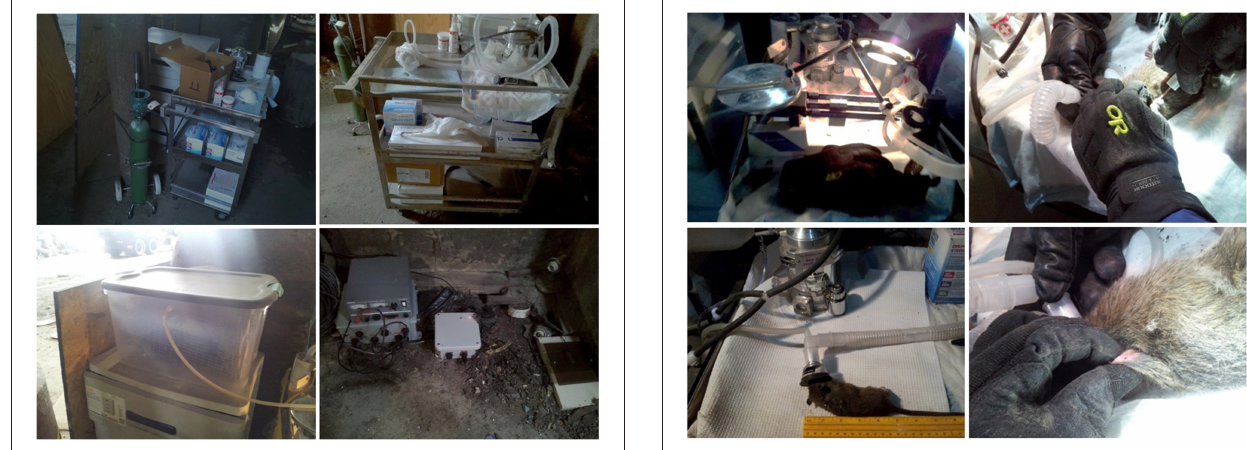
FIGURE 1 | Mobile anesthetic lab and outdoor RFID system for wild Norway rats, Rattus norvegicus , captured on Eastern Long Island and monitored from January 14–May 15.